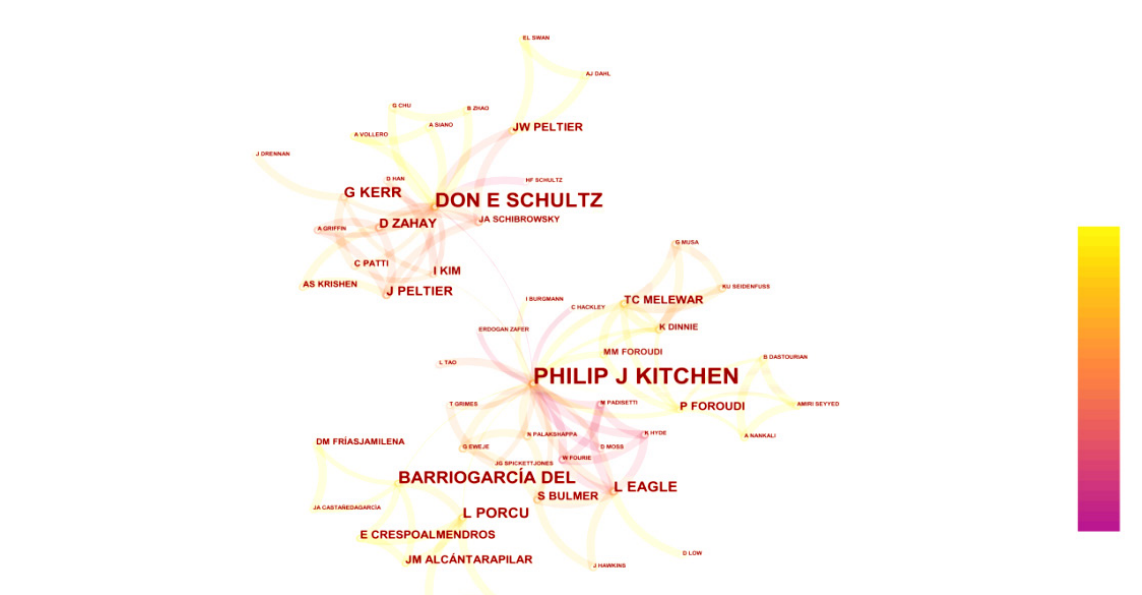
Figure 6. Author co-occurrence map (Scopus database)